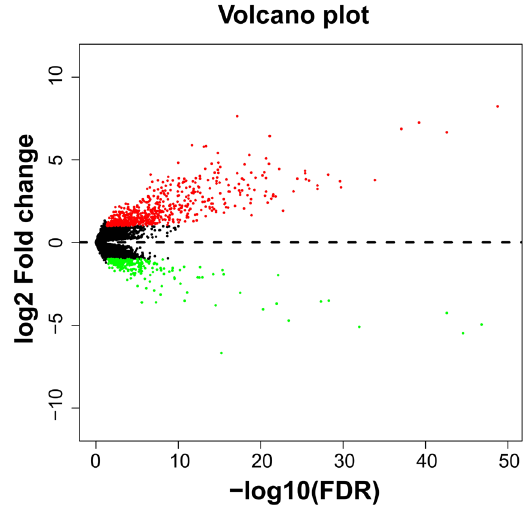
Figure 8: Volcano plot of DEGs between low - and high - risk score phenotypes in